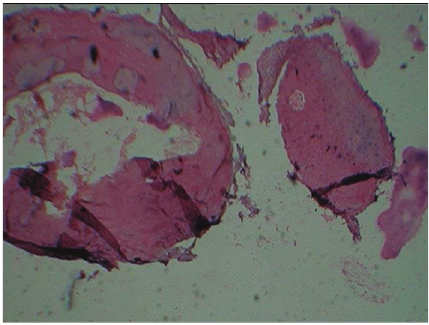
Figure 3: 10x scanner view H&E